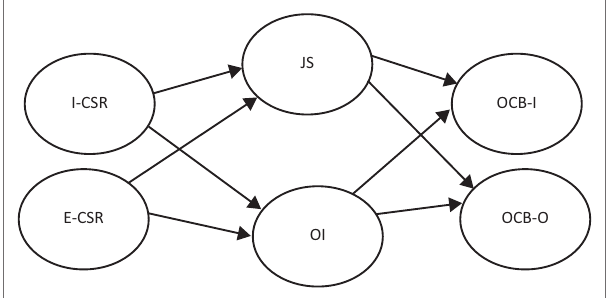
FIGURE 1: The theoretical